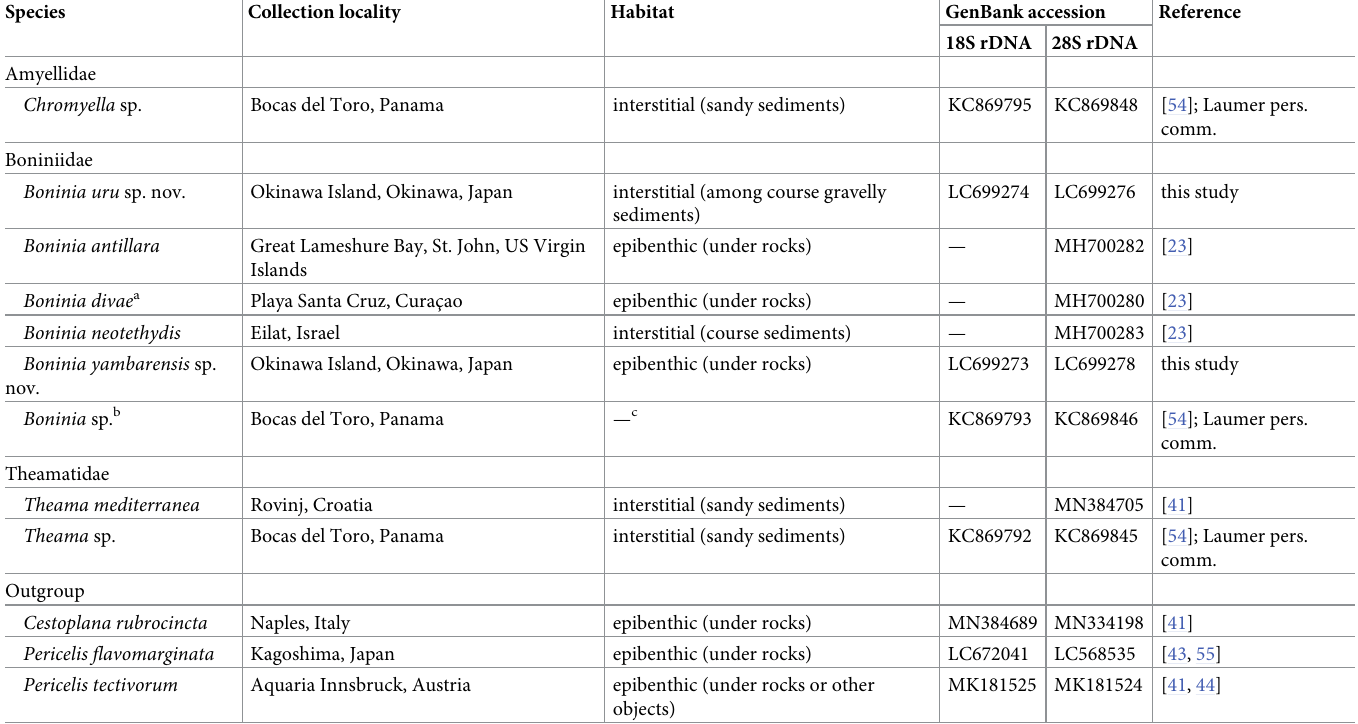
Table 3. List of species used for the molecular phylogenetic analysis, and their respective collection localities and habitats, GenBank accession numbers, and